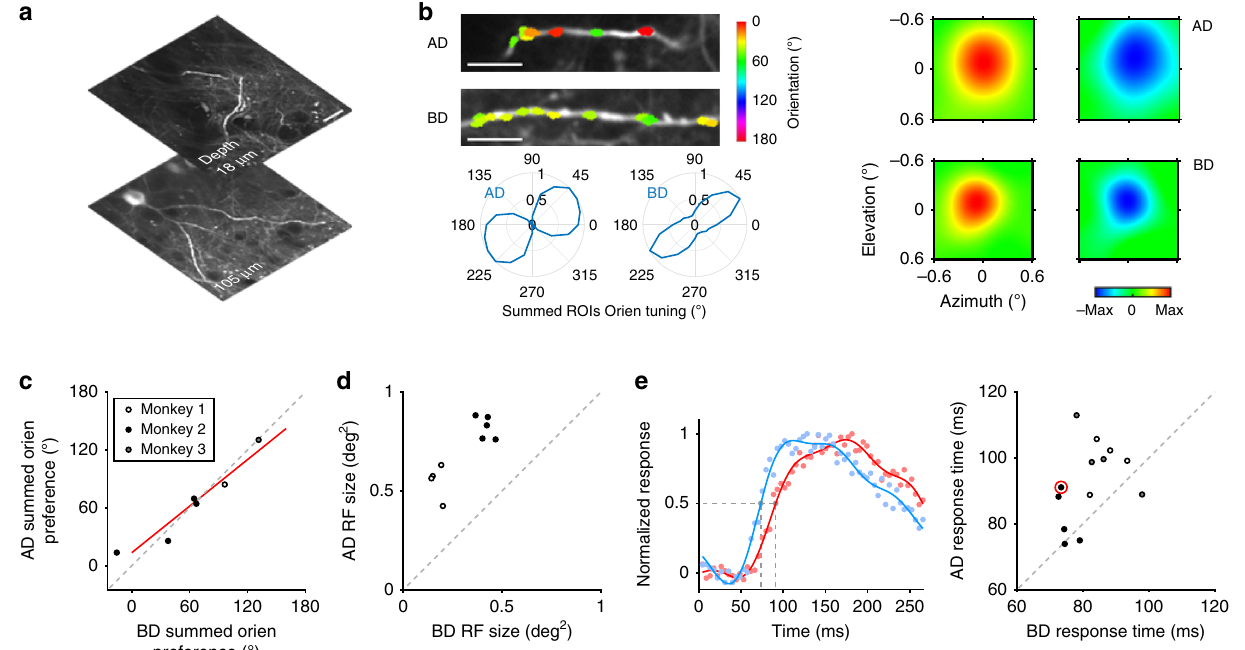
Fig. 5 Comparison of excitatory dendritic inputs on apical dendrites vs. those on basal dendrites. a Apical and basal dendritic shafts of one example neuron (recorded at depths of 18 and 105 μ m, respectively, on Day 88). The images were averaged across 1000 frames. Scale bar, 20 µ m. b Orientation preference and RF of dendritic inputs on AD and BD. Top left, orientation preferences of ROIs on AD and BD, respectively, colored for vector sum polarity for each ROI. Lower left, summed orientation preference of all orientation-selective ROIs on AD and BD respectively (AD, 18 ROIs on two dendrites; BD, 43 ROIs on three dendrites). Right, example RFs of two ROIs on AD and BD, respectively. c Summed orientation preference of orientation-selective ROIs on AD and BD of each neuron (neurons with <15 ROIs on their AD were discarded). Red line, linear fi t ( p = 2 × 10 − 3 ); gray dashed line, unity line. R 2 = 0.87 when fi tted to the unity line. d AD RF size (mean of ON and OFF RF sizes) vs. BD ’ s of each neuron. e Time courses of response on AD vs. BD. Left, normalized fl uorescence traces on AD (red) and BD (blue) of the example neuron. Dots, raw data points; lines, Fourier fi t; gray dashed lines, marking response time points according to half-height. Right, AD response time vs. BD ’ s of each neuron. The example neuron was designated with a red